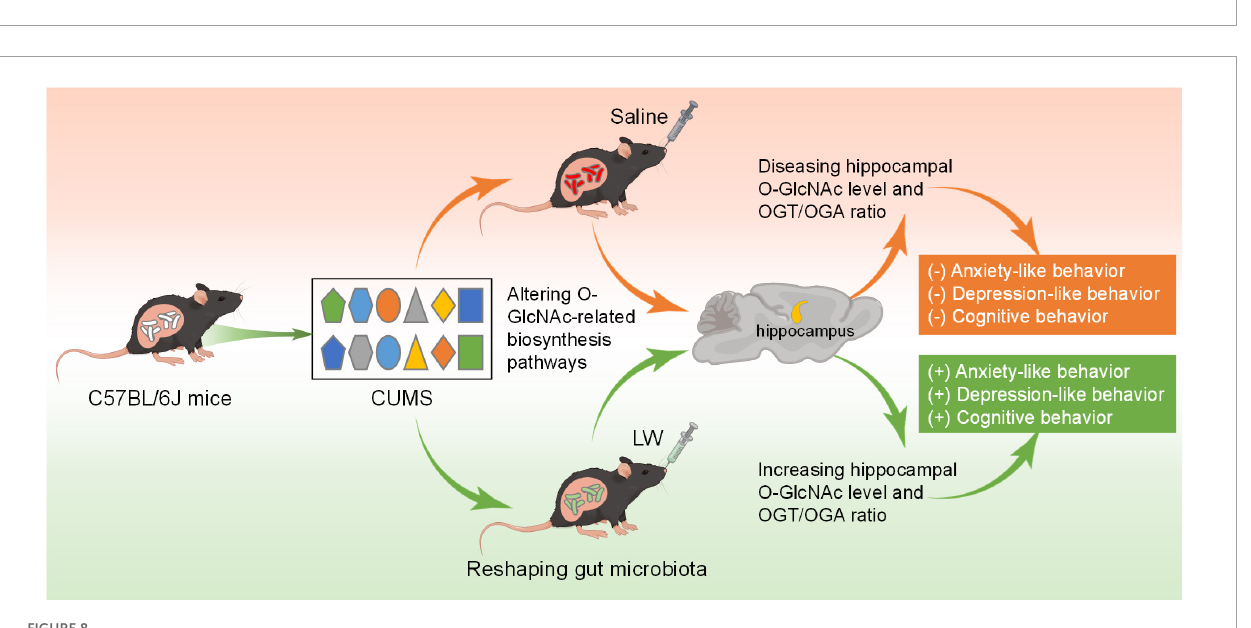
biosynthesis (M00909 and M00892) (Umapathi et al.,